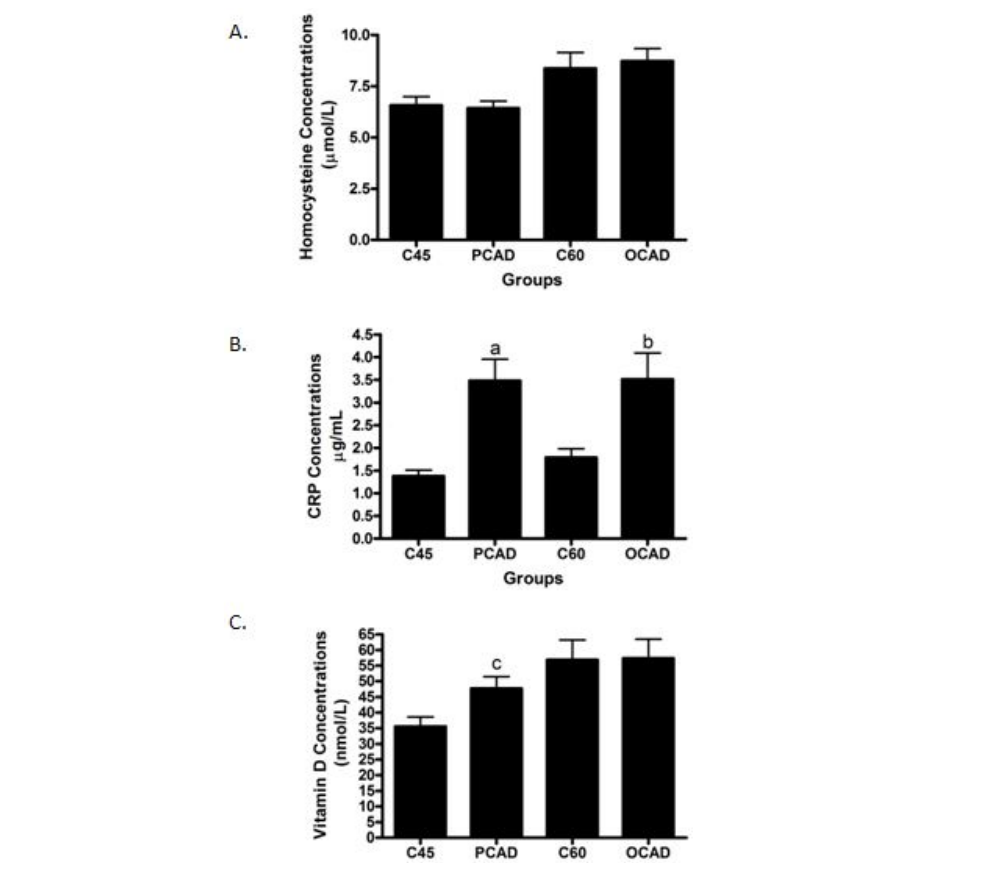
Figure 5. The concentration levels of ( A ) homocysteine, ( B ) CRP, and ( C ) vitamin D in PCAD and OCAD cases and control subjects. a p < 0.001 compared to C45 using t -test analysis; b p = 0.016 compared to C60 using Mann–Whitney analysis; and c p = 0.016 using t -test analysis. Subsequently, we conducted a correlation analysis between the biomarkers amongst Table 2. Pearson correlation between parameters in PCAD. ** Correlation was significant at p < 0.01; the PCAD subjects. Plasma sVCAM-1 was found to be positively correlated with IL-6 (r = 0.63) and IL-10 (r = 0.734). Plasma IL-6 also showed a positive association with homocys- * correlation was significant at p < teine (r = 0.477,) and IL-10 levels (r = 0.436). Furthermore, significant positive associations were found between plasma Apo-A1 with IL-2 (r = 0.472) and Apo-E levels (r = 0.583) and between plasma vitamin D with IL-10 levels (r = 0.436). In the OCAD group, positive cor- relations were found between plasma homocysteine with Apo-E (r = 0.584) and plasma sVCAM-1 with IL-10 levels (r = 0.562). Correlation analysis for all parameters among the PCAD and OCAD subjects are shown in Tables 2 and 3, respectively.